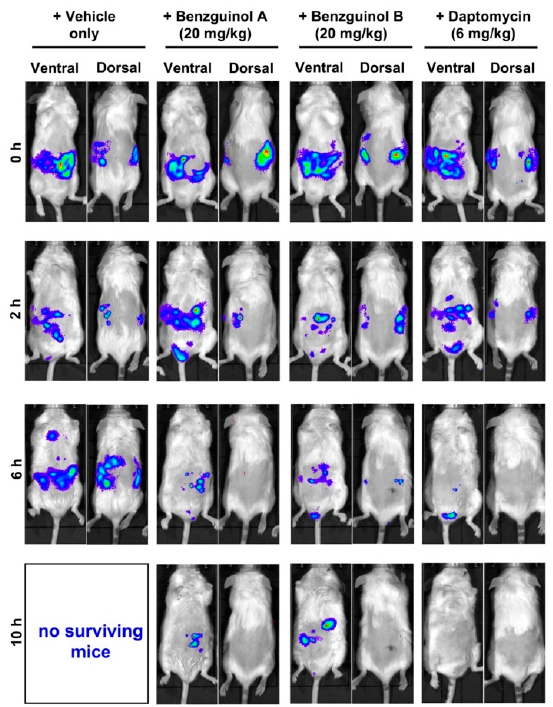
Figure 8. Ventral and dorsal images of representative CD1 mice challenged with approximately 6 × 10 7 CFU of bioluminescent S. aureus ATCC 12600 (Xen29). Mice were treated with benzguinol A or benzguinol B (20 mg/kg), daptomycin (6 mg/kg), or vehicle at 2, 6, and 10 h. Mice were subjected to bioluminescence imaging on IVIS Lumina XRMS Series III system at the indicated times. At 8 h post-infection, all mice treated with vehicle only had become moribund, indicated by “no surviving mice” at 10